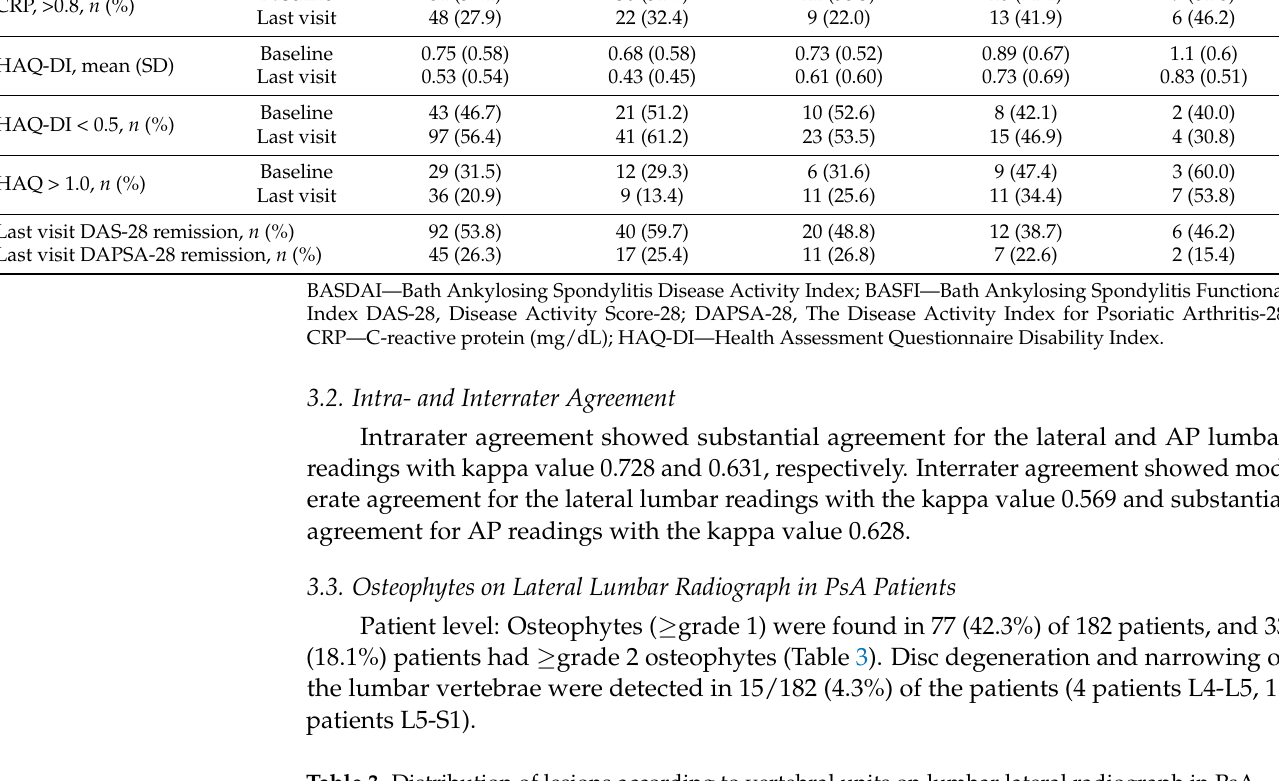
Table 3. Distribution of lesions according to vertebral units on lumbar lateral radiograph in